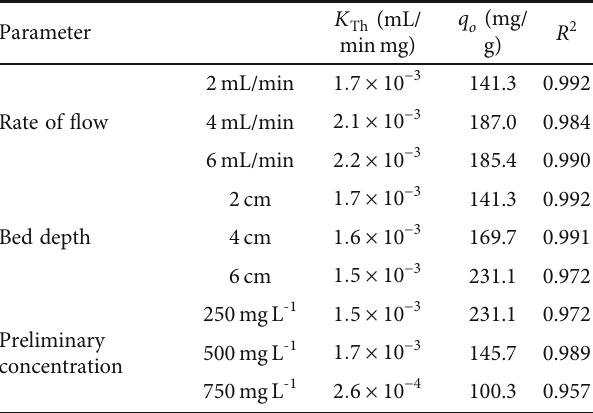
Table 3: Thomas model parameters for the removal of Pb 2+ ions by ZSM-5/AC from aqueous